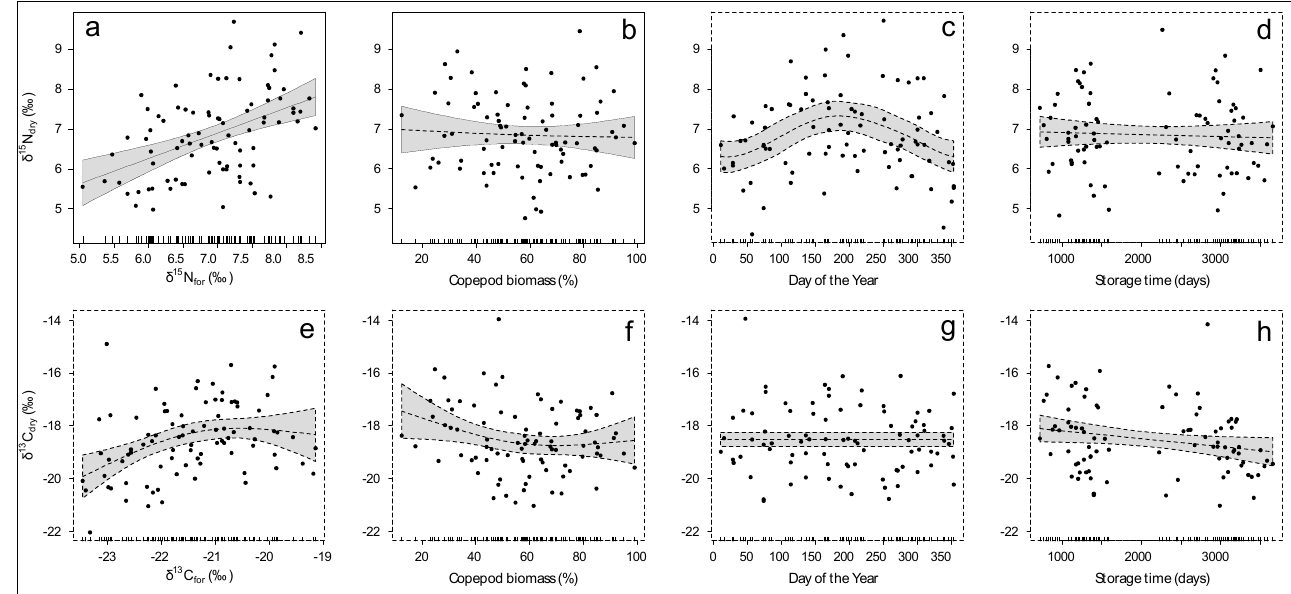
Figure 4. Partial effects plots obtained from fitting a GAM to ( a – d ) δ 15 N dry or ( e – h ) δ 13 C dry data. Shown are the effects for ( a , e ) formalin, ( b , f ) copepod contribution to total biomass (%), ( c , g ) seasonality (day of the year), and ( d , h ) storage time in formalin. Significant (non-significant) trends are indicated by continuous (dashed) lines. Bands indicate 95% confidence intervals and the rugs along the x-axes display the distribution of the data. Table 2. Results of the generalised additive models (GAMs) fitted to the isotope measures. SE: standard error; EDF: estimated degrees of freedom; p : significance.; N: number of data; r 2 adj : adjusted determination